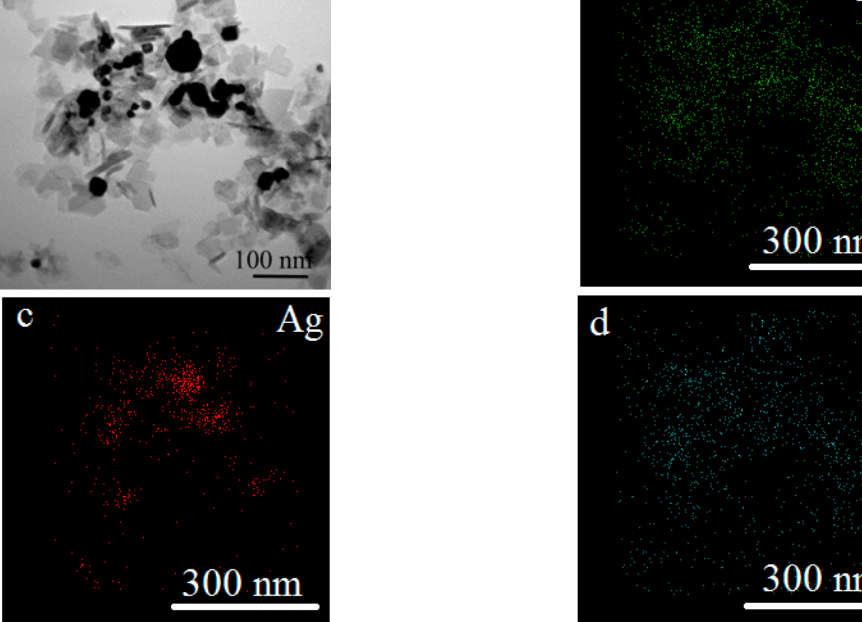
Figure 7. TEM image ( a ) and TEM-EDS mapping ( b – d ) of nanoscale structures obtained under HTO (sample 3).